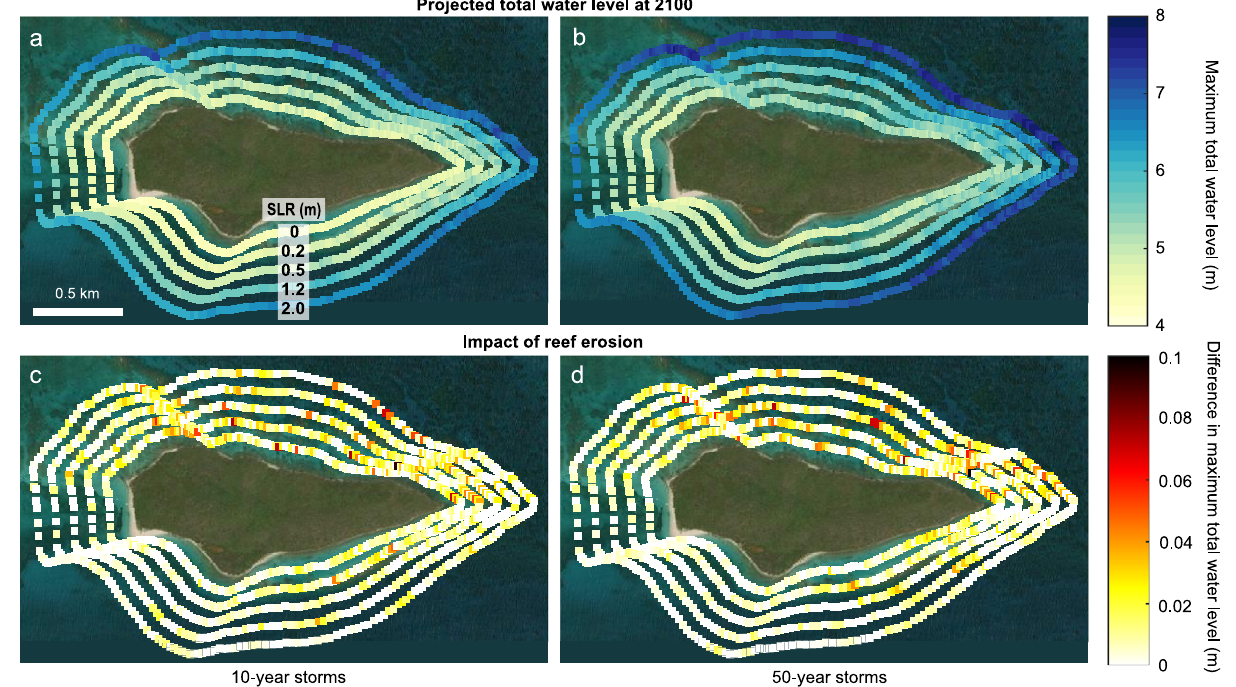
Fig. 4 | Maps displaying the impact of sea-level rise and coral-reef bathymetry on alongshore variation in total water levels and thus coastal fl ooding potential. In each panel, the maximum total water levels are plotted along the shoreline of Buck Island, with each ring of points representing a sea-level rise scenario, from +0.0m (inner ring)to +2.0m (outerring).Left ( a , c ) andright ( b , d ) columnspresentresultsfor10-yearstorm(i.e.,astrongtropicalstormorCategory- 1 hurricane 32 ) and 50-year storm scenarios (i.e., a Category-5 hurricane 32 ), respec- tively. The top row ( a , b ) provides projections of maximum total water levels at 2100 with projected reef erosion from the carbonate-budget models under the